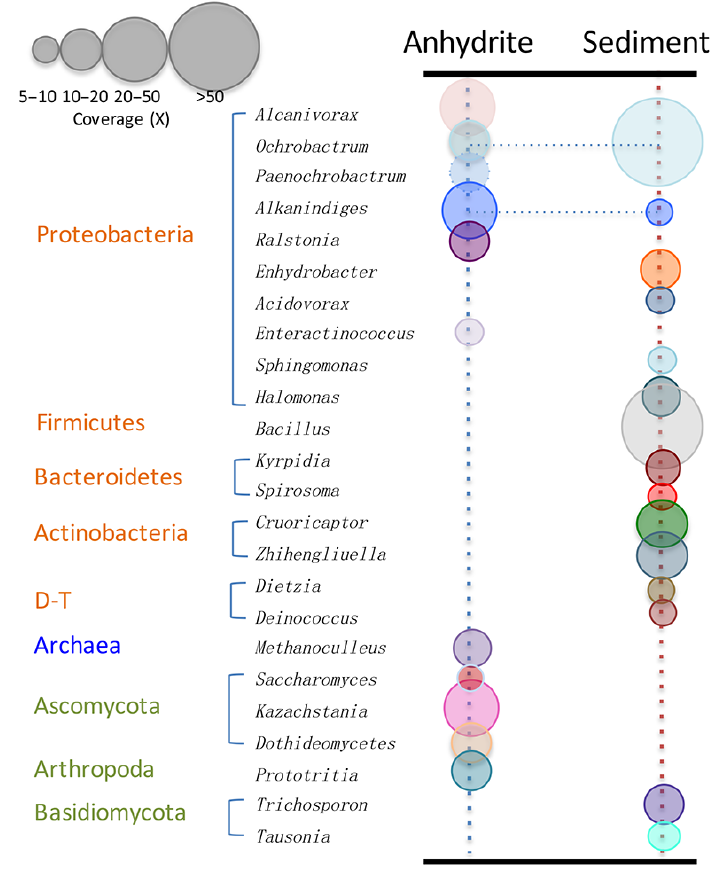
Figure 4. Microbial communities in anhydrite crystals and neighboring control sediment. Phyla and genera in the anhydrite crystals and control layer were predicted using 16S/18S rRNA gene fragments extracted from the corresponding metagenomes (D-T: Deinococcus- Thermus). The relative abundance of the genera can be estimated by the coverage level (>5) of the 16S/18S rRNA fragments by